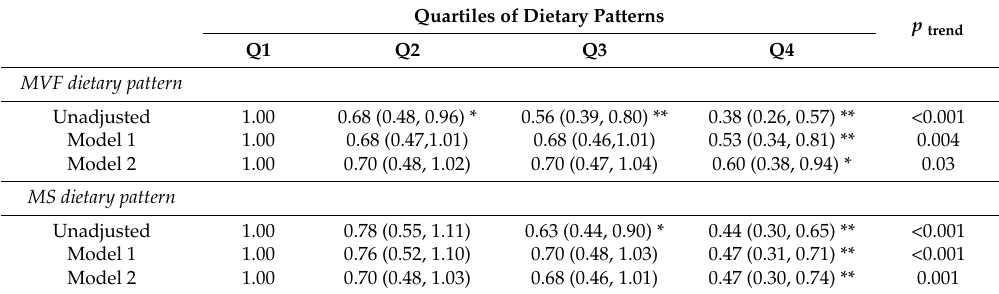
Table 4. Associations of dietary patterns scores with cognitive impairment using logistic regression a,b .